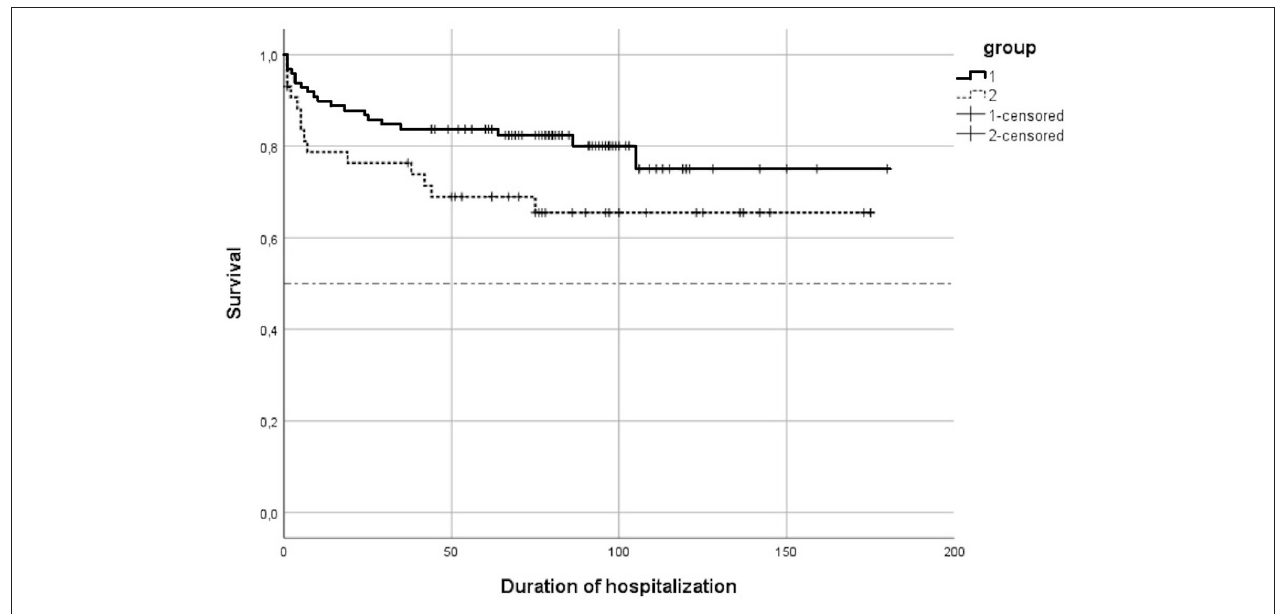
FIGURE 1 | Survival curve.